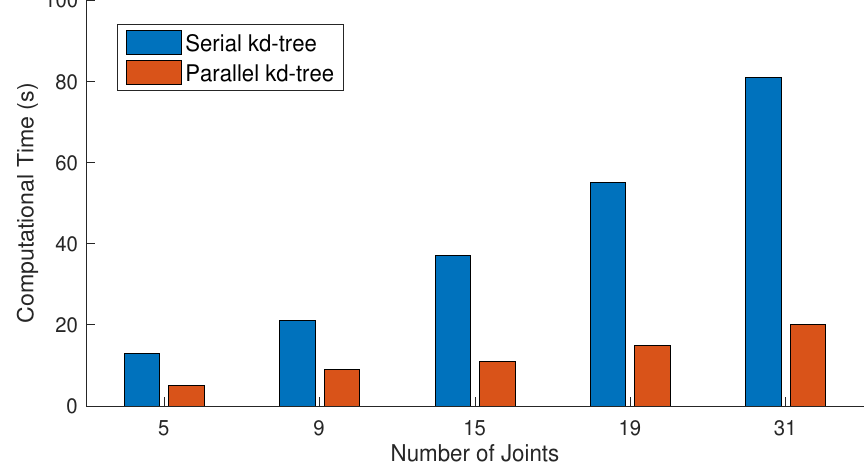
Figure 12. Comparative analysis of serial and parallel construction of k d-tree when the sizes of dataset and query are 65,535 and 2048, respectively. The number of nearest neighbors is fixed to 64 for these